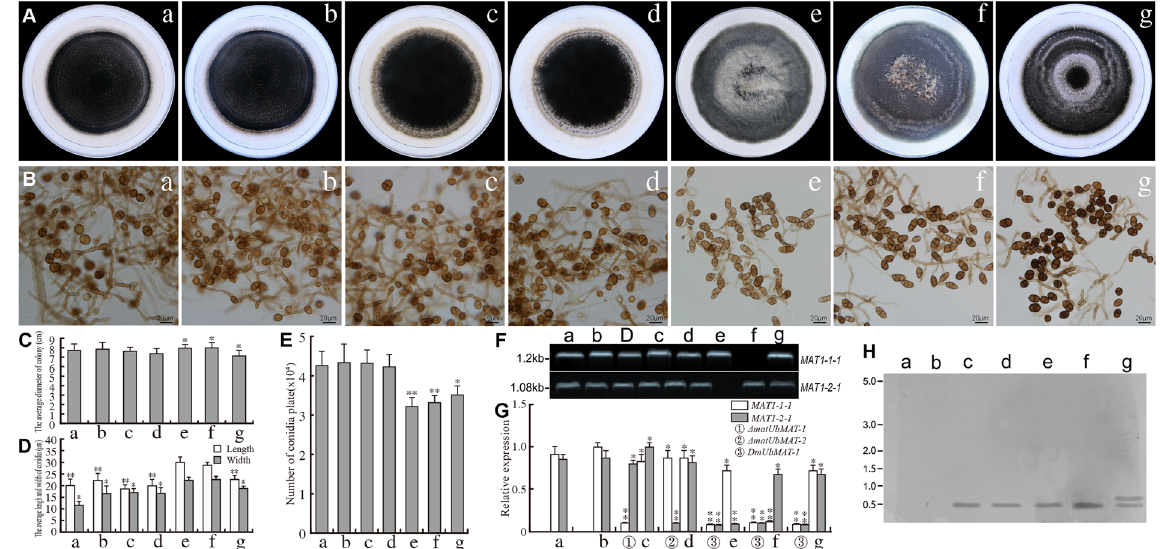
Figure 2. Effect of heterologous expression of C. heterostrophus MAT genes on asexual morphology in U. botrytis strains of MAT deletion lines. ( A , C ) Growth and diameter of colonies across the different transgenic lines at 12 days after incubation. Colony growth rates were determined from at least 25 plates. ( B , D ) Variation in conidial size. L = Length, W = Width. The average size of conidia were determined from at least 50 conidia. Photographs were taken at 12 days after incubation. ( B , E ) Variation in conidial number. Number of conidia produced per plate from cultures grown on PCA plates for 12 days under standard conditions. ( F ) PCR analysis of MAT gene transcription in different transgenic lines. D-DNA template of WT. ( G ) qRT-PCR analysis of mRNA expression levels of MAT1-1-1 and MAT1-2-1 in individual heterologous transgenic lines, relative to the constitutive control genes. WT and CK were used as negative controls. Actin gene was used as the reference gene. Error bars represent standard errors calculated using three biological replicates for each sample. ‘ * ’ indicates a significant difference from WT ( P < 0.05) using a Student’s t - test . ‘ ** ’ indicates a significant difference from WT ( P < 0.01) using a Student’s t-test . ( H ) For Southern blot analysis, both hygB and G418 specific probes were used to detect transgene insertion as shown in Table S1. WT and CK have no hygB and G418 specific insertion. a WT (Wild-type U. botrytis ), b CK is an empty vector transformant. c Δ matUbMAT- 1 { ChMAT } -1 , d. Δ matUbMAT-2 { ChMAT } -1 , e DmUbMAT-1 { ChMAT } -1-1 , f. DmUbMAT-1 { ChMAT } -2-1 , g DmUbMAT-1 { ChMAT } -3-1 . Each experiment was repeated at least three